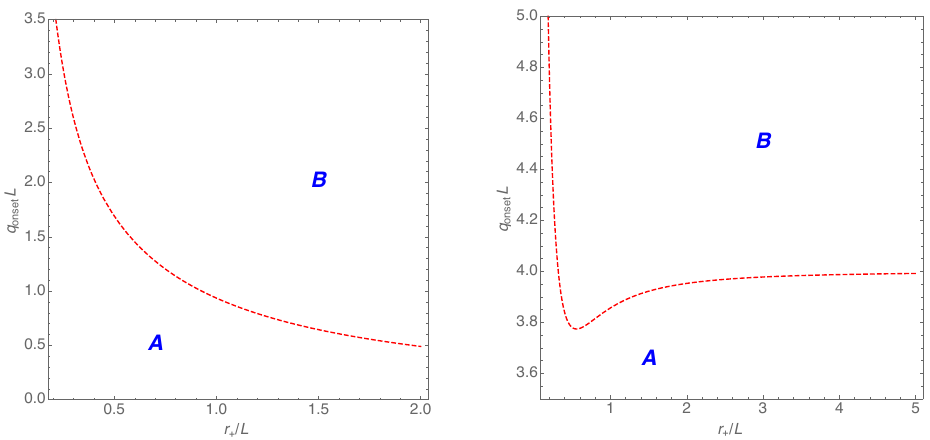
Figure 5 . Predicted Dirac (cid:12)eld charge for the onset of an instability as a function of the horizon radius for an extremal AdS-RN black hole ( (cid:22) = (cid:22) ext ). In both plots the red dashed curve is the lower bound of (4.4). The plot in the left ( right ) panel is for fermion mass mL = 0 ( mL = 4) and harmonic number ‘ = 1 = 2. The near-horizon analysis of the 2-dimensional stability bound violation leading to (4.4) predicts that region B should be unstable while region A should be stable (at least with respect to the stability mass bound mechanism). Note that for small r + =L the system is